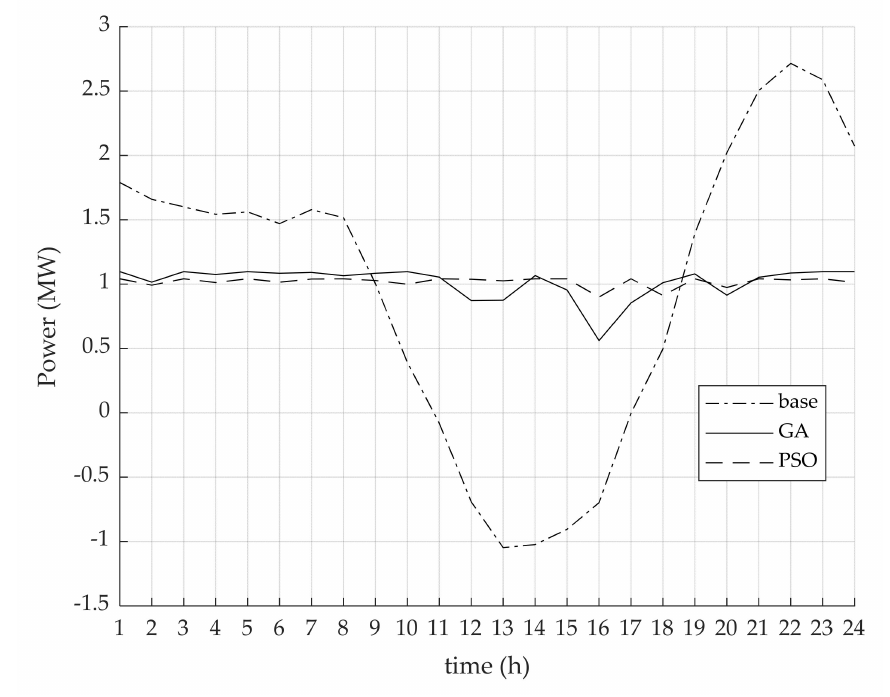
Figure 5. Peak demand profile at the slack bus.